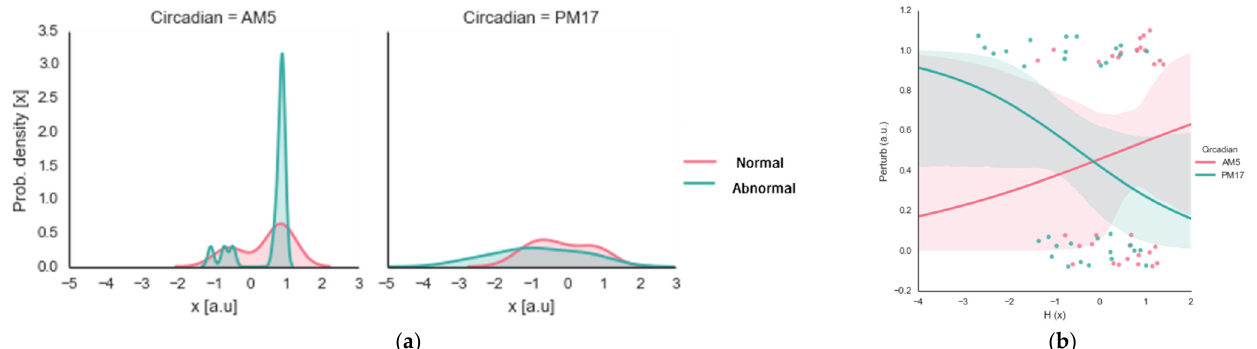
Figure 4. Circadian and temperature perturbation (heat-based)-dependent influences: ( a ) shows the data double-plotted with the variation in a histogram and the kernel density function (vertical axis = probability density, horizontal axis = entropy production; False = normal, True = perturbation; Circadian AM = 5:00 in the morning, Circadian PM = 5:00 in the afternoon); ( b ) shows the relationships between the entropy (horizontal axis) and perturbation (vertical axis) for the different circadian points (red line and dots denote 5:00 h; blue line and dots denote 17:00 h).